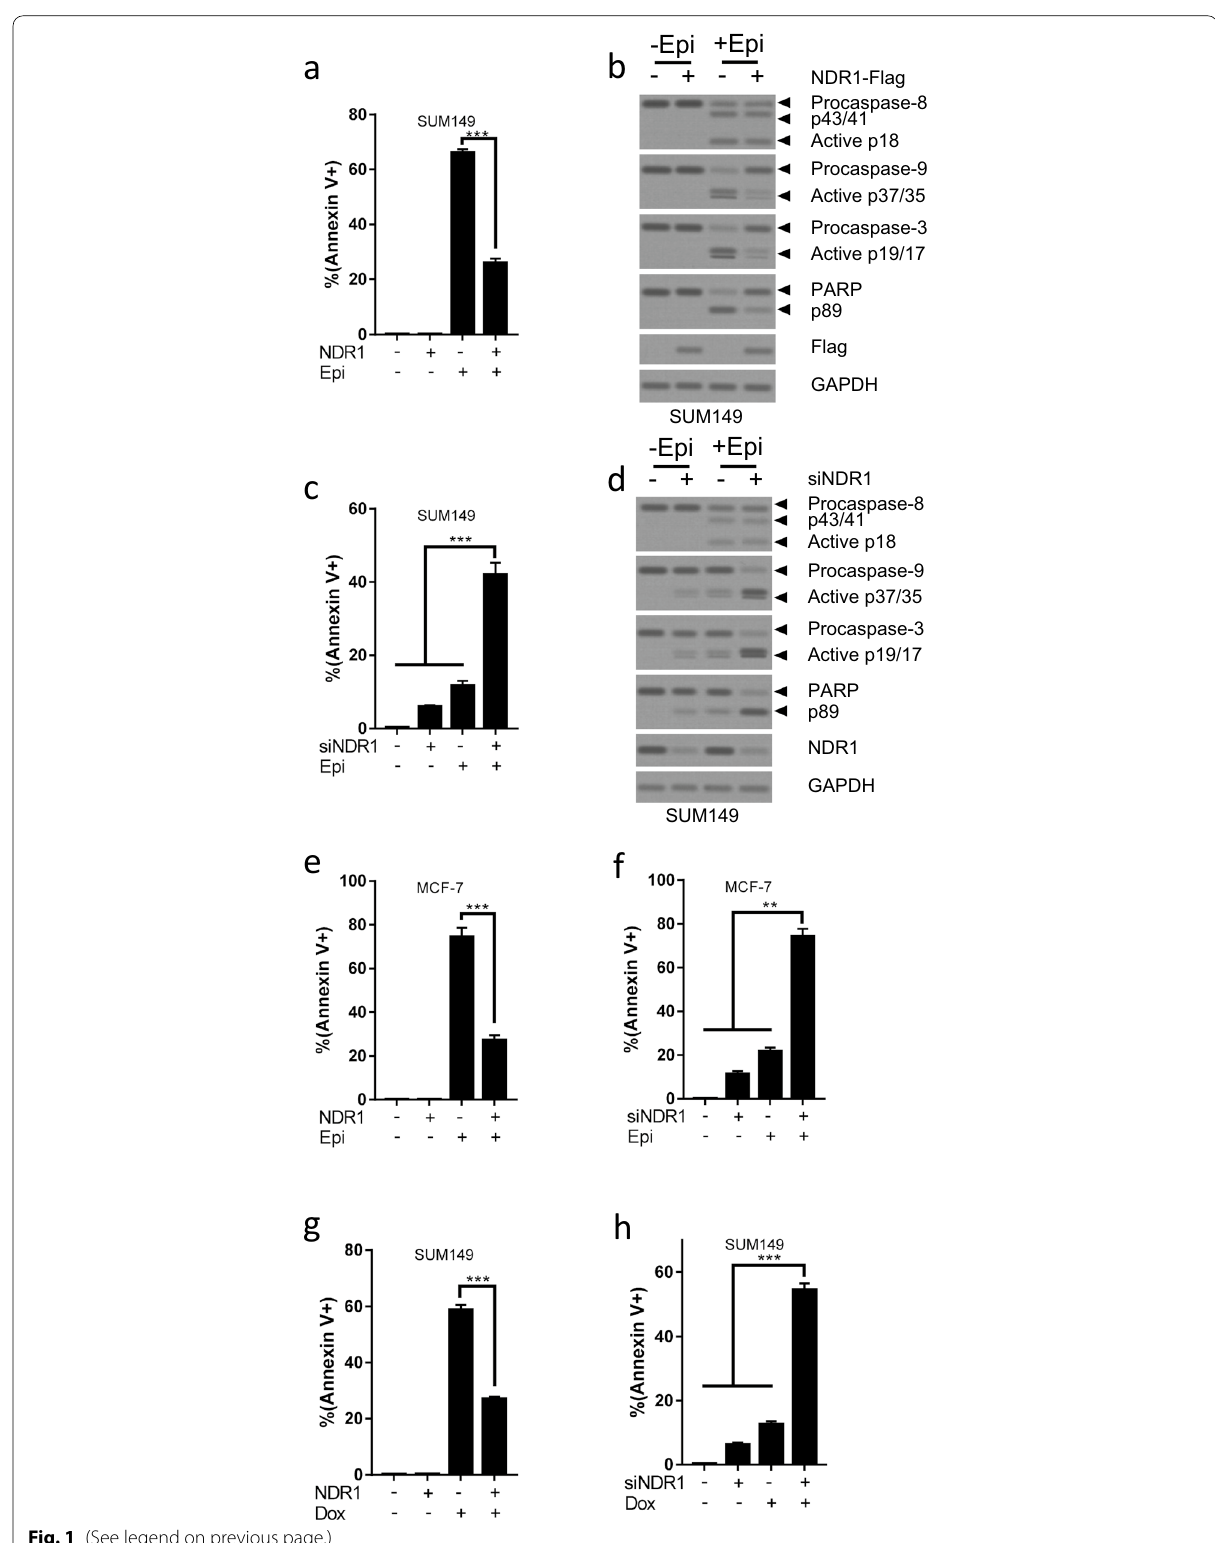
Fig. 1 (See legend on previous